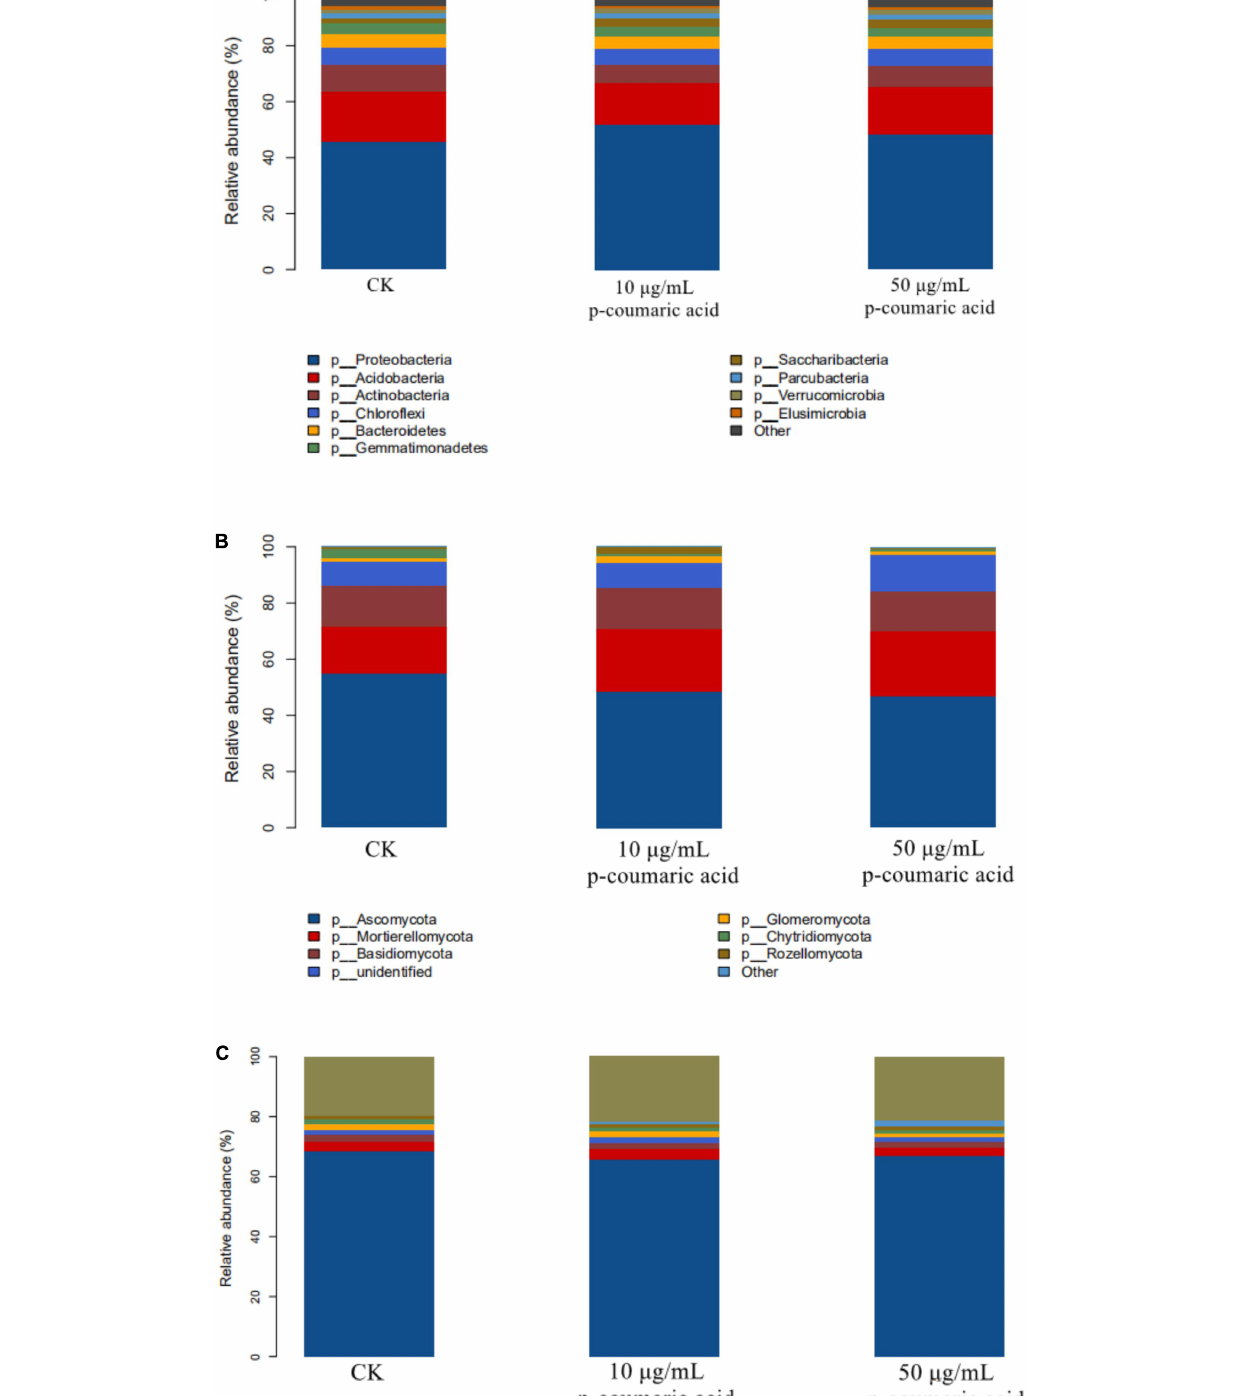
Frontiers in Microbiology |